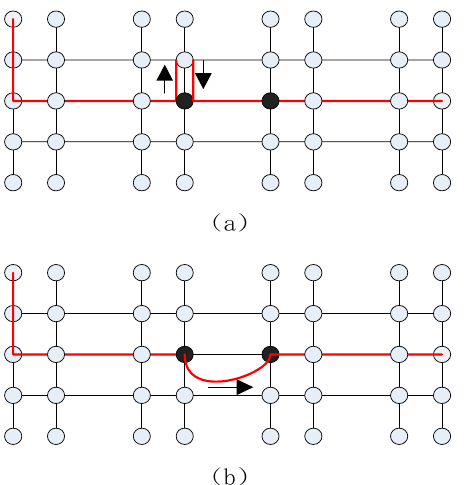
Figure 11. Path comparison: ( a ) path based on traffic rules and ( b ) path based on the bi-level path planning algorithm.